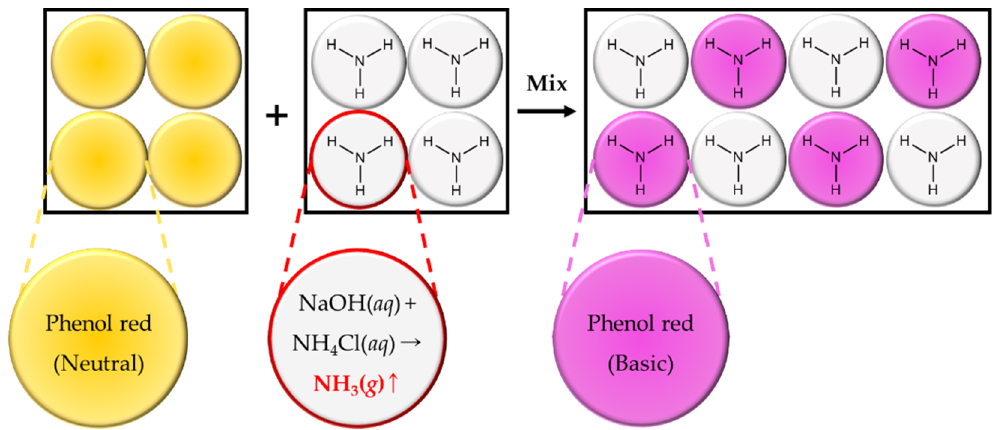
Figure 11. Schematic diagram of artificially produced ammonia gas within droplets and its crosstalk between droplets. Biosensors 2020 , 10 , x FOR PEER REVIEW